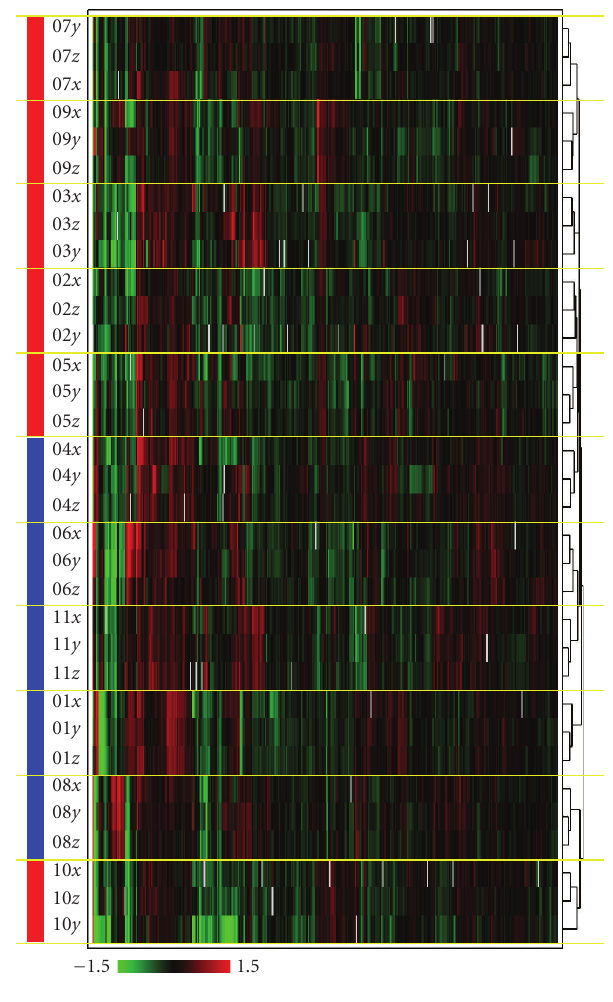
Figure 4: Hierarchical clustering of the 33 samples ( y -axis) based on the abundance of the 397 high-quality protein spots on the x - axis, using Euclidean distance and average linkage. The samples are in SubjectNumberTime format, where SubjectNumber ranges from 01 to 11, and the Time values { x , y , and z } correspond to { T 1 , T 2 , and T 3 } . The intensities range from − 1.5-fold change (bright green) to 1.5-fold change (bright red). The dendrogram on the right indicates the order of the sample grouping, with more similar samples being grouped together first. The color band on the left shows the genders of the samples, with red for females, and blue for males.